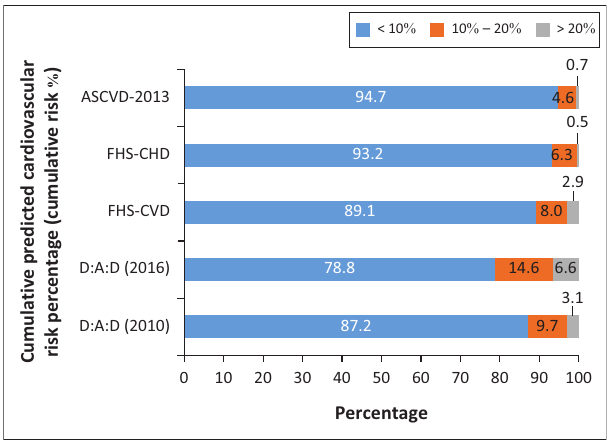
CVD, Cardiovascular Disease; D,A,D, Data Collection on Adverse Events of Anti-HIV Drugs; ASCVD, Atherosclerotic Cardiovascular Disease Risk Score; FHS-CHD, Framingham Heart Study-Coronary Heart Disease; FHS-CVD, Framingham Heart Study-Cardiovascular Disease FIGURE 3: Cardiovascular disease risk categories. The 10-year cardiovascular disease risk is depicted in three categories, low (< 10 % ), medium (10 % – 20 % ), and high (> 20 % ).